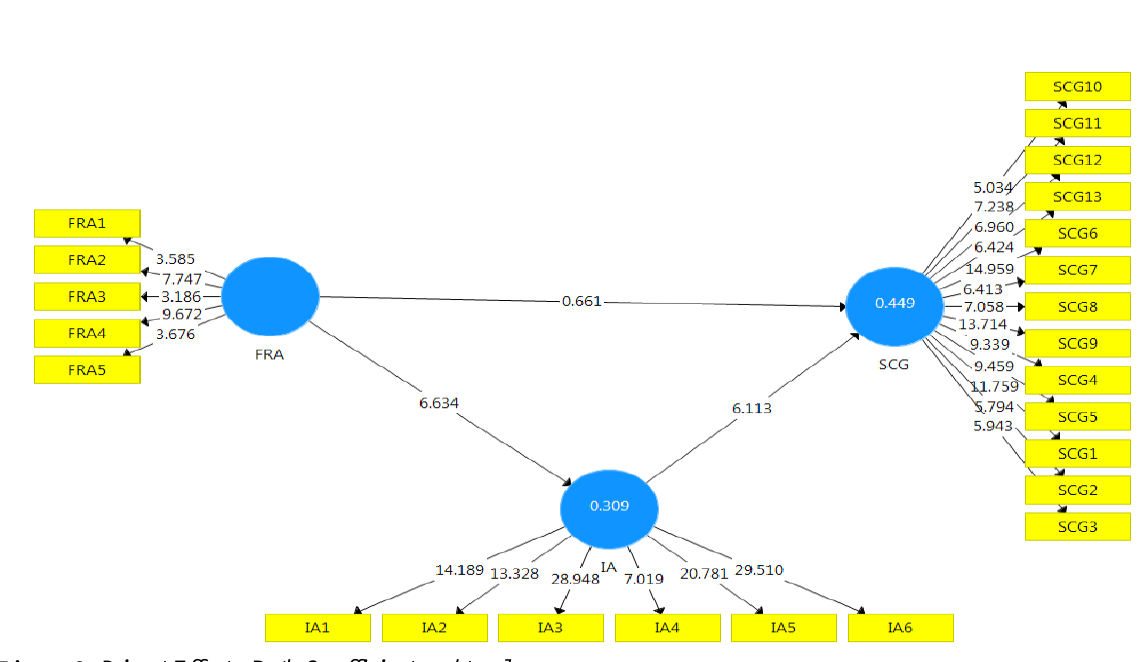
Figure 2: Direct Effect - Path Coefficient and